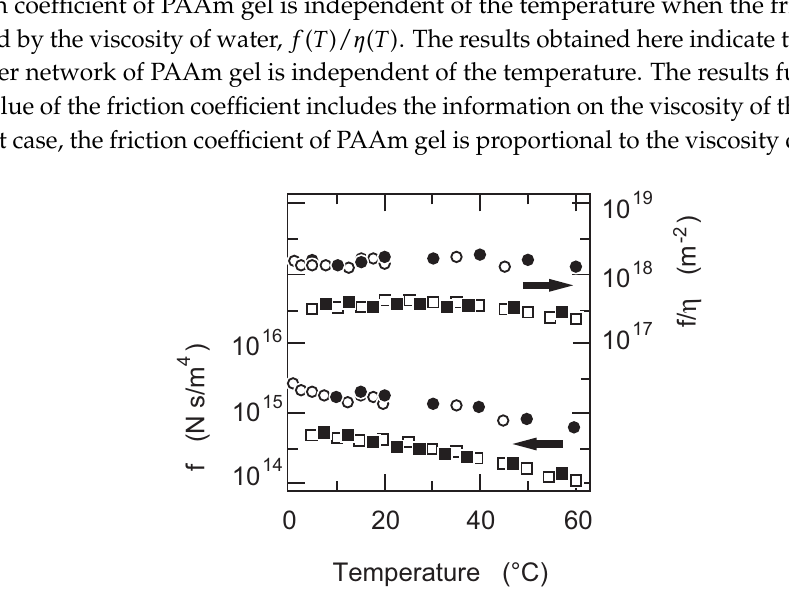
Figure 5. The temperature dependence of the friction coefficient of poly(acrylamide) (PAAm) gel. The concentration of gel is 5 % (squares) and 8% (circles). The friction coefficient that is normalized by the viscosity of water, f ( T ) / η ( T ) is also shown in this figure. The solid symbols are used in the increasing of the temperature, and the open symbols are used in the decreasing of the